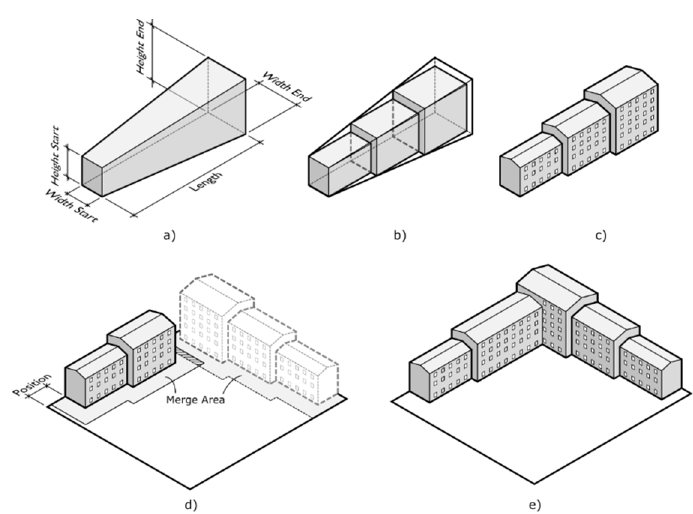
Figure 4. Outline of the building generation technique used in the case study, where ( a ) shows the definition of the building’s bounding shape, ( b ) shows the fit of cuboids into the bounding shape, ( c ) shows the initially generated building(s), ( d ) shows the positioning of the building(s) and merge areas, and ( e ) shows a scenario where two adjacent buildings are merged.